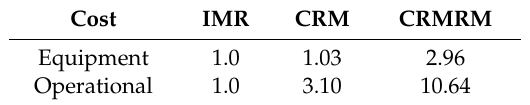
Table 2. Equipment and operational cost on the single optimal solution for each configuration